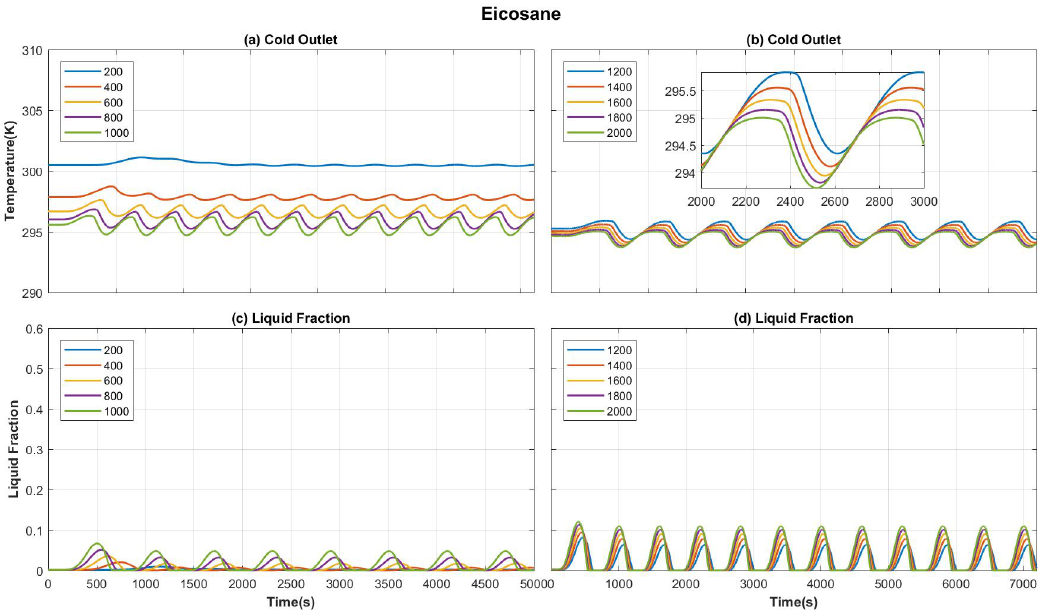
Figure 6. Cold outlet temperature and liquid fraction for eicosane ( T s = 309.35 K, T l = 310.35 K) at Reynolds from 200 to 2000. Reynolds 200–1000 on the left ( a , c ) and 1200–2000 on the right ( b , d ). Liquid fractions are shown in ( c , d ) show low usage of the PCMs full phase change capacity with ( b , d ) showing a trend of lower average temperature of the flow with higher PCM